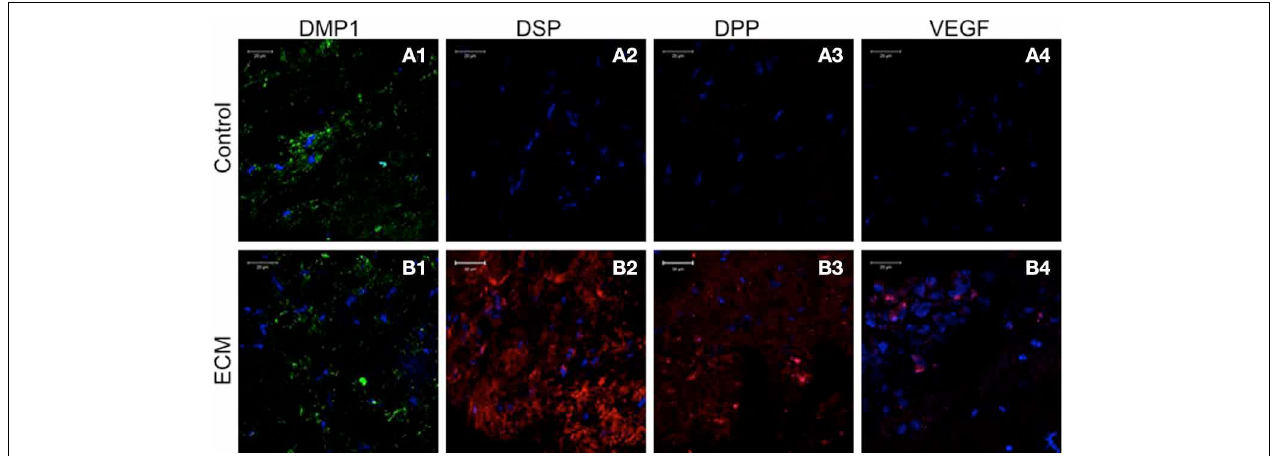
FIGURE 5 | DPSC immunohistochemistry. The fluorescent images are representative confocal micrographs of sections from DPSC seeded scaffold explants consisting of control collagen/chitosan scaffold (A) and pulp ECM scaffold (B) . The sections were analyzed for the expression of